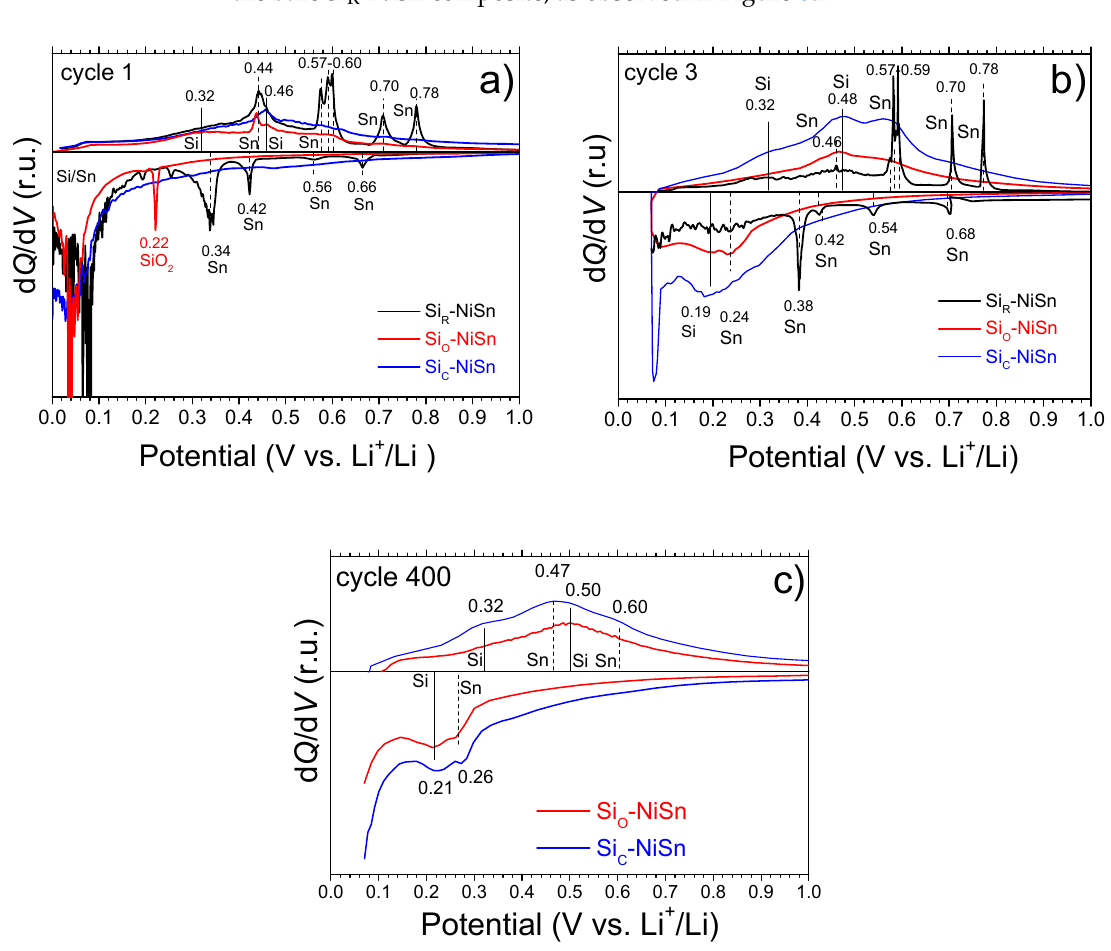
Figure 7. Differential capacity plots for all composites at cycles ( a ) 1, ( b ) 3 and ( c ) 400. Solid and dashed vertical lines have been used to identify formation/decomposition of Li y Si and Li z Sn alloys, respectively.